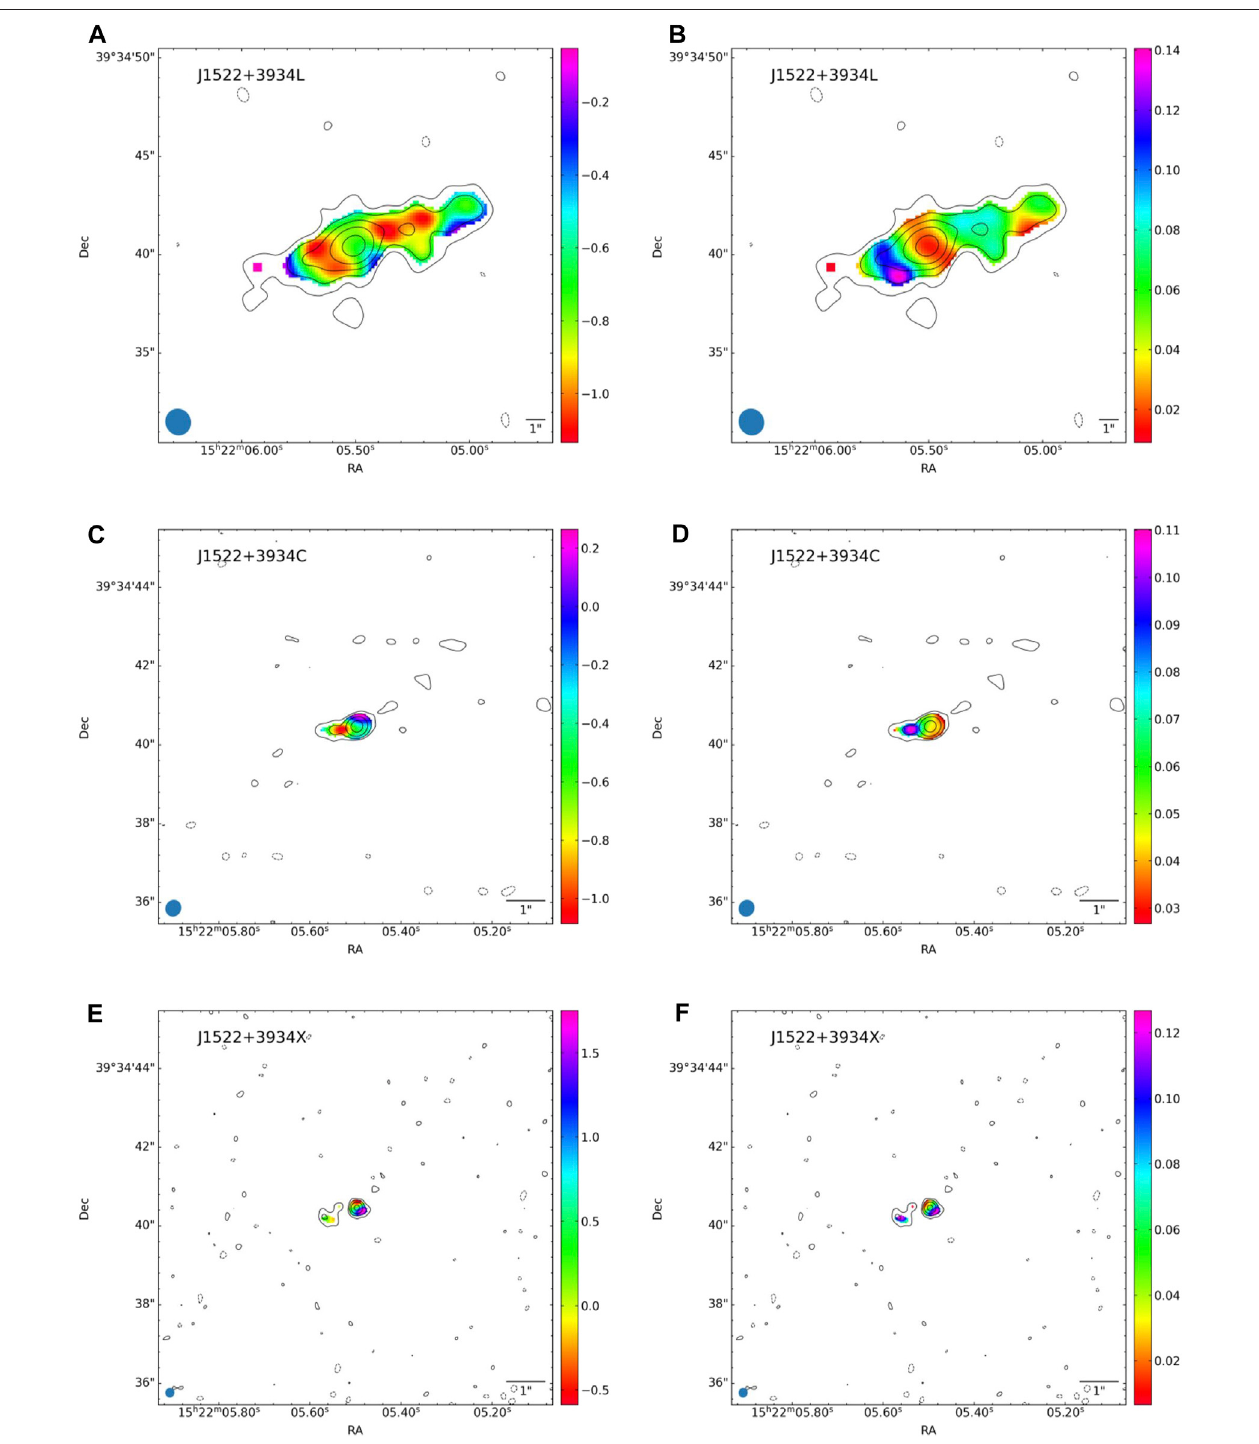
FIGURE 3 | (A) 1.6 GHz α map, rms (cid:1) 17 µ Jy beam − 1 , beam size 2.26 × 2.13 kpc; (B) 1.6 GHz Δ α map; (C) 5.2 GHz α map, rms (cid:1) 10 µ Jy beam − 1 , beam size 0.73 × 0.66 kpc; (D) 5.2 GHz Δ α map; (E) 9.0 GHz α map,rms (cid:1) 7 µ Jybeam − 1 ,beamsize0.41 × 0.38 kpc (F) 9.0 GHz Δ α map.Contourlevelsat − 3,3 × 2 n , n ∈ [0,4]in (A) and (B) , and n ∈ [0, 3] in (C – F) . The scale is 1.650 kpc/arcsec.